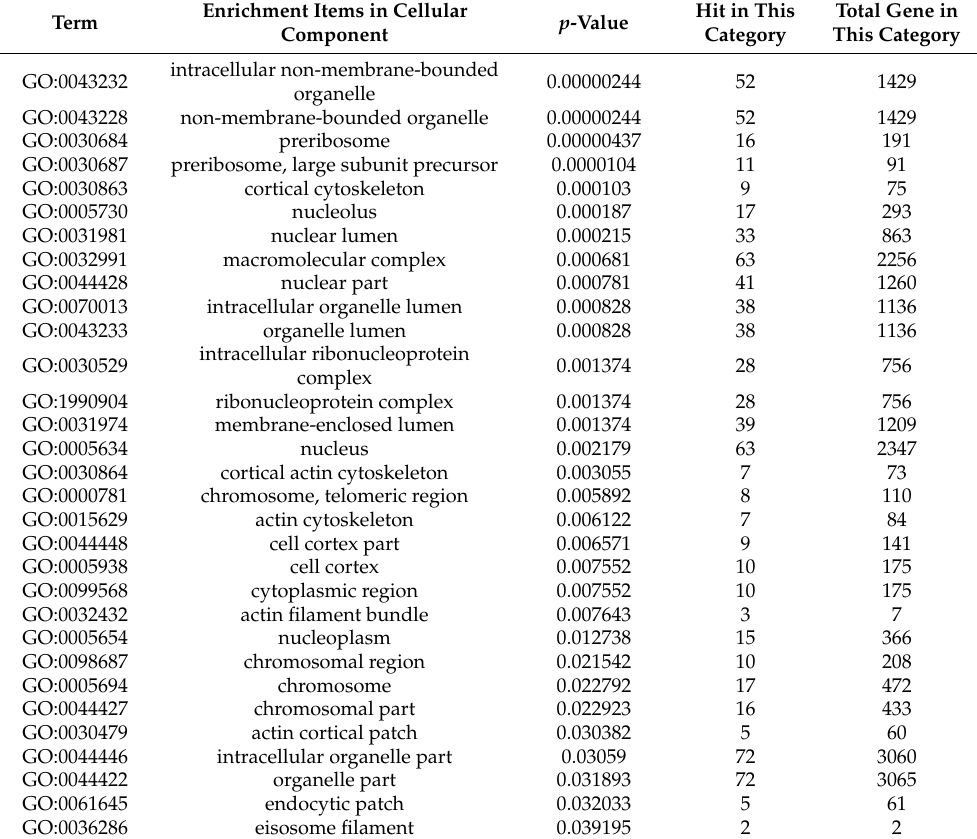
Table 3. Enriched items in cellular component of gene ontology for the protein targets of penetratin.